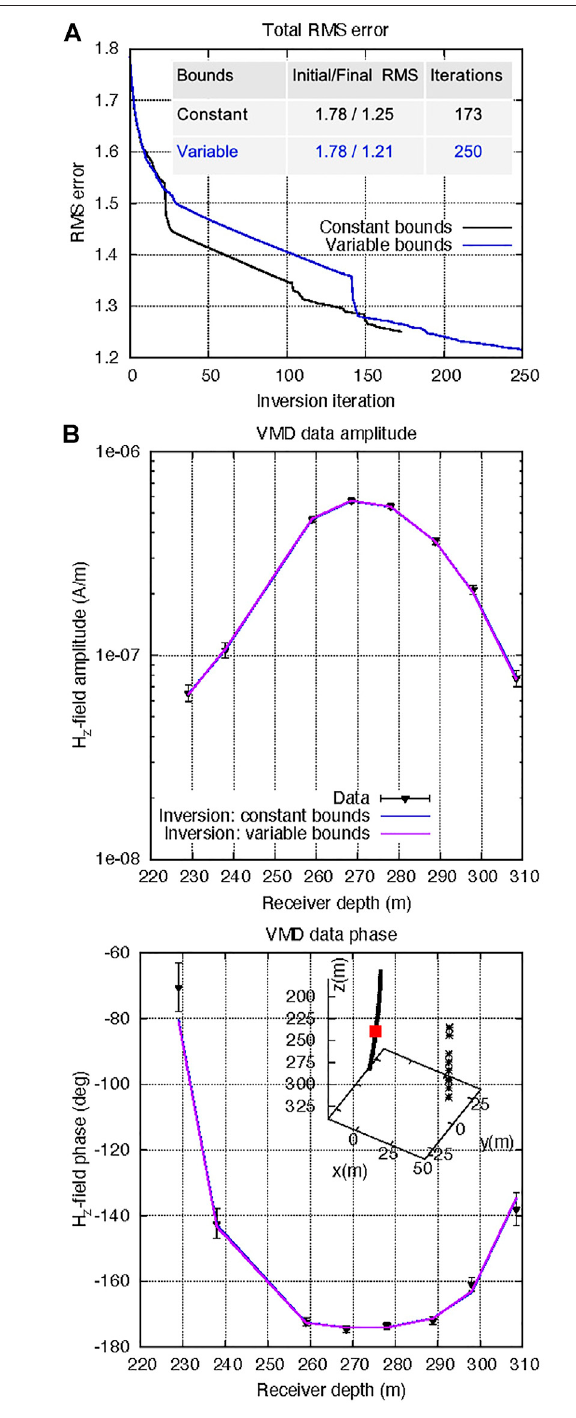
FIGURE 12 | (A) : Inversion of CaMI.FRS fi eld data with variable parameter bounds. The inversion is initialized with the layered starting model ( M 1 D ) obtained from 1D inversion ( Figure 9 ). Shown are deviations Δσ var (cid:2) M 3 D var − M 1 D where M 3 D var is the fi nal model update. Only deviations | Δ σ | > 0 . 075 S/m are visualized, where blue and red regions